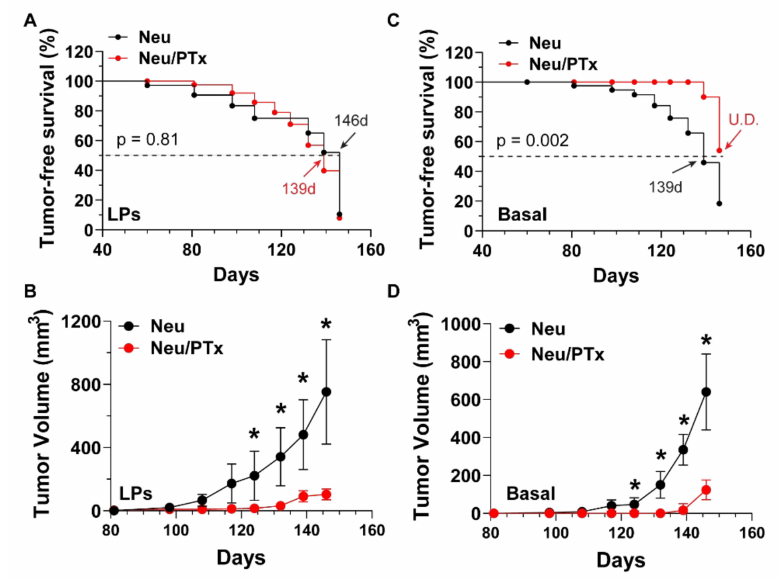
Figure 2. Blocking Gi/o-GPCR signaling suppresses the tumor-forming capacity of breast CSCs in vivo. A total of 10,000 and 5000 of luminal progenitor (LPs; ( A , B )) and basal (basal; ( C , D )) cells isolated from Neu and Neu/PTx mice were orthotopically implanted into the mammary gland of nude mice, and tumor growth was measured via caliper. ( A , C ) Tumor-free survival curves;